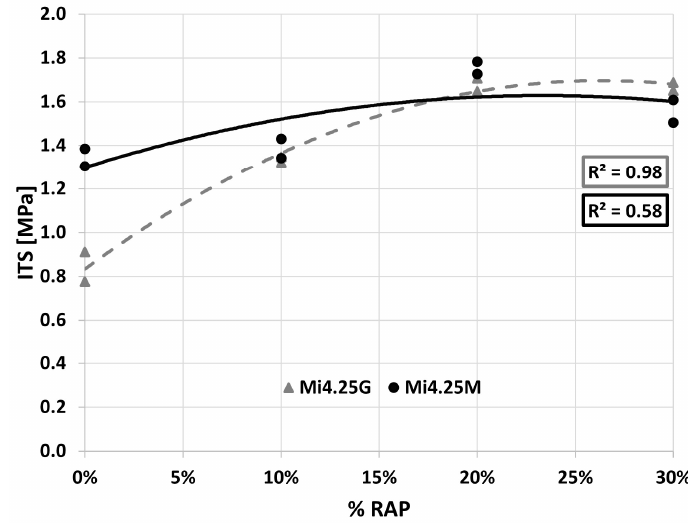
Figure 7. Mi4.25k ITS curves.